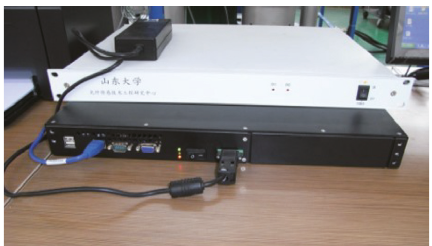
Figure 3: Data acquisition and the actual system